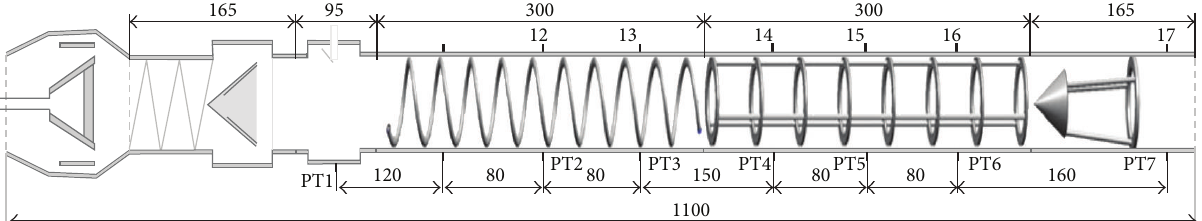
Figure 5: Schematic view of the small scale pulse detonation engine test setup with Shchelkin spiral and obstacle blockage [32].